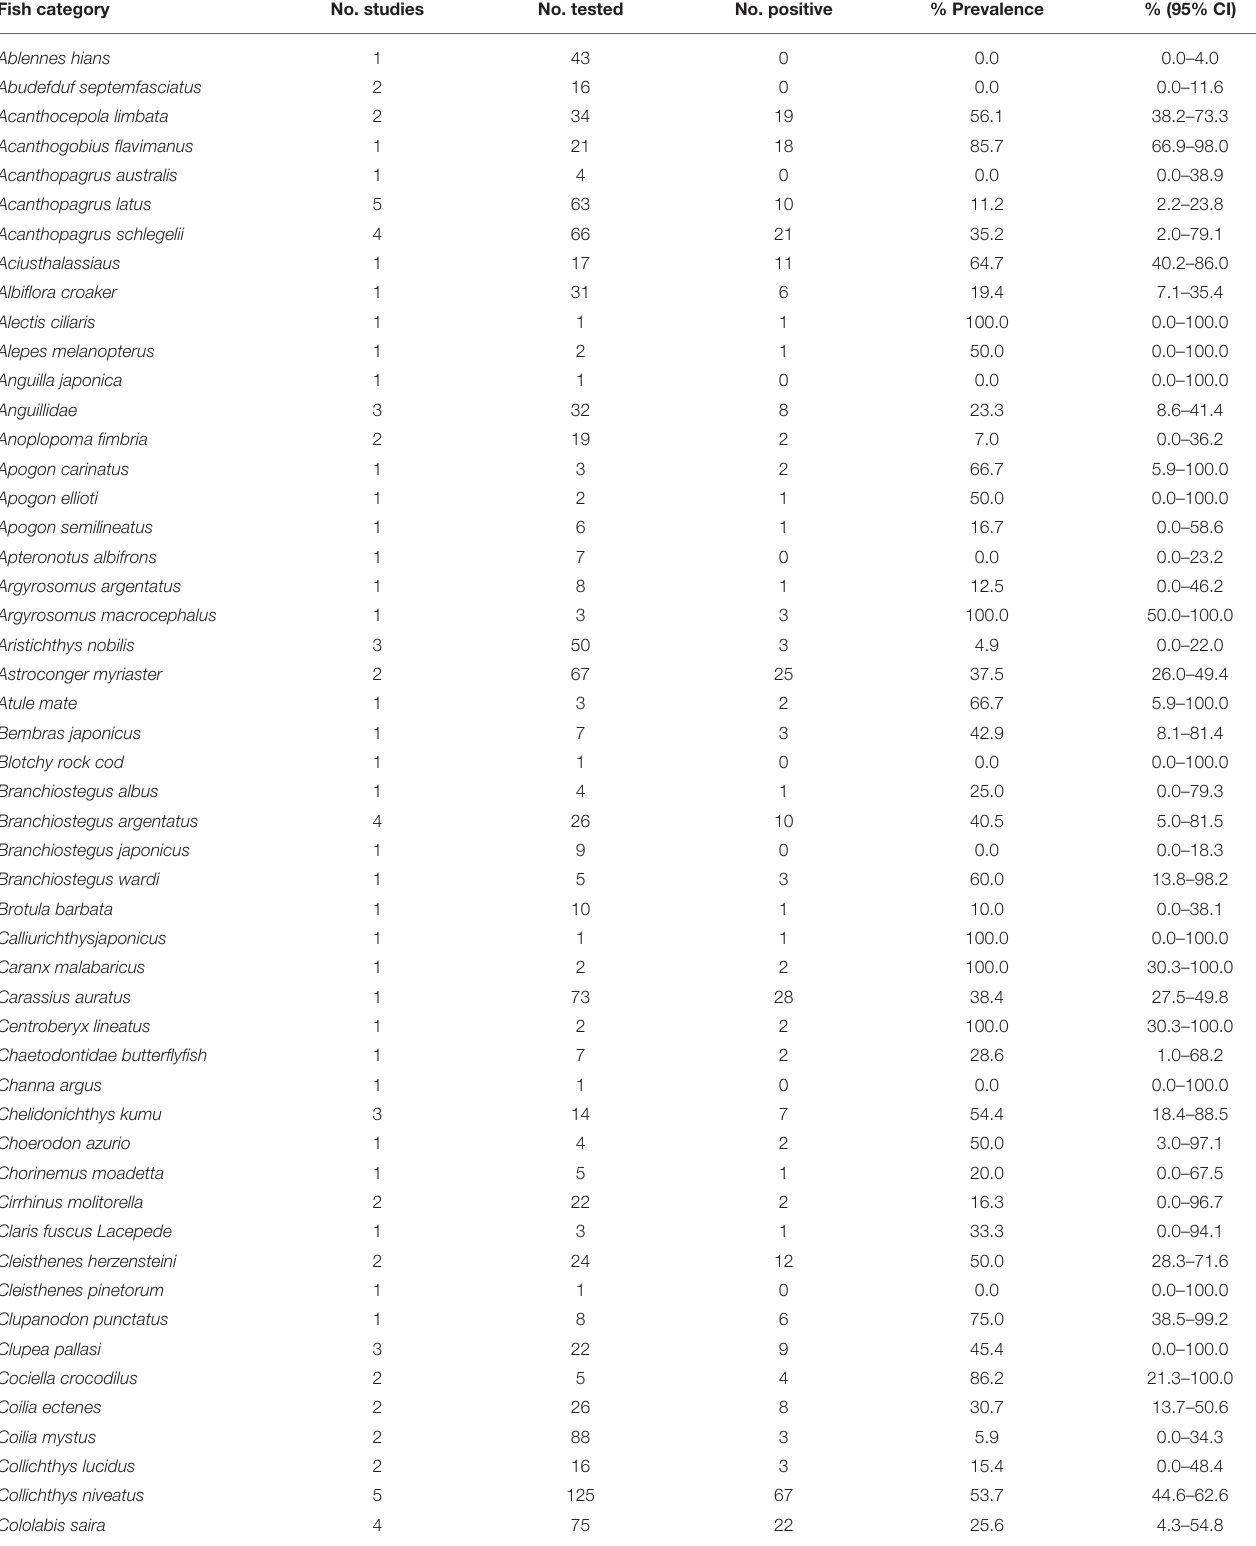
TABLE 5 | Estimated pooled prevalence in different species of